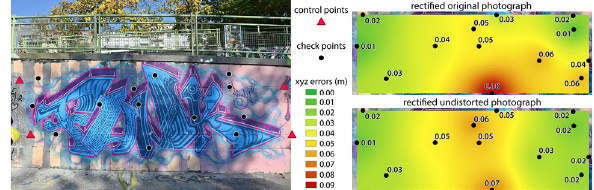
Figure 6 . A graffito photo (left) and the error distribution of its planarly rectified variants with and without lens distortion